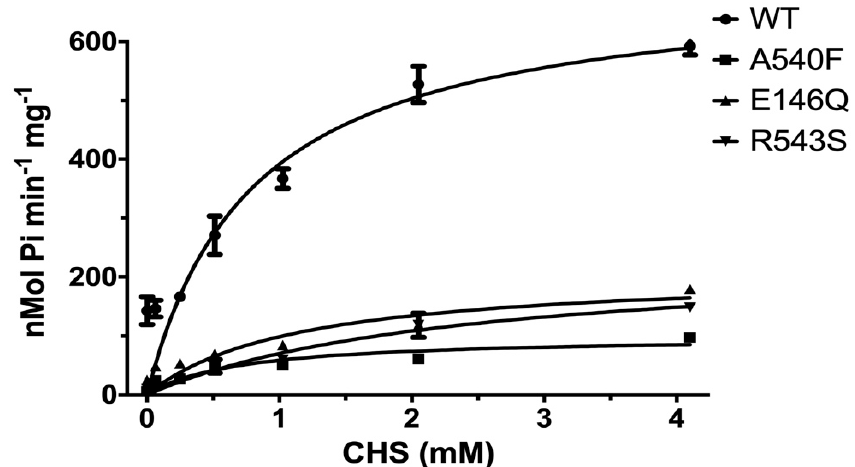
Figure 6. CHS dependence of ABCG5/G8 ATPase activity. Purified proteins were assayed in the presence of E. coli polar lipids, and the specific activities of ATP hydrolysis were obtained by the CHS concentration-dependent experiments (0–4.1 mM CHS). The curves are fitted to the Michaelis–Menten equation (Prism 8), and, using two independently purified proteins, the means of at least two independent experiments along with standard deviations are plotted here. The kinetic parameters are listed in Table 2. Table 2. Dependence of ABCG5/G8 ATPase activity on cholesteryl hemisuccinate.